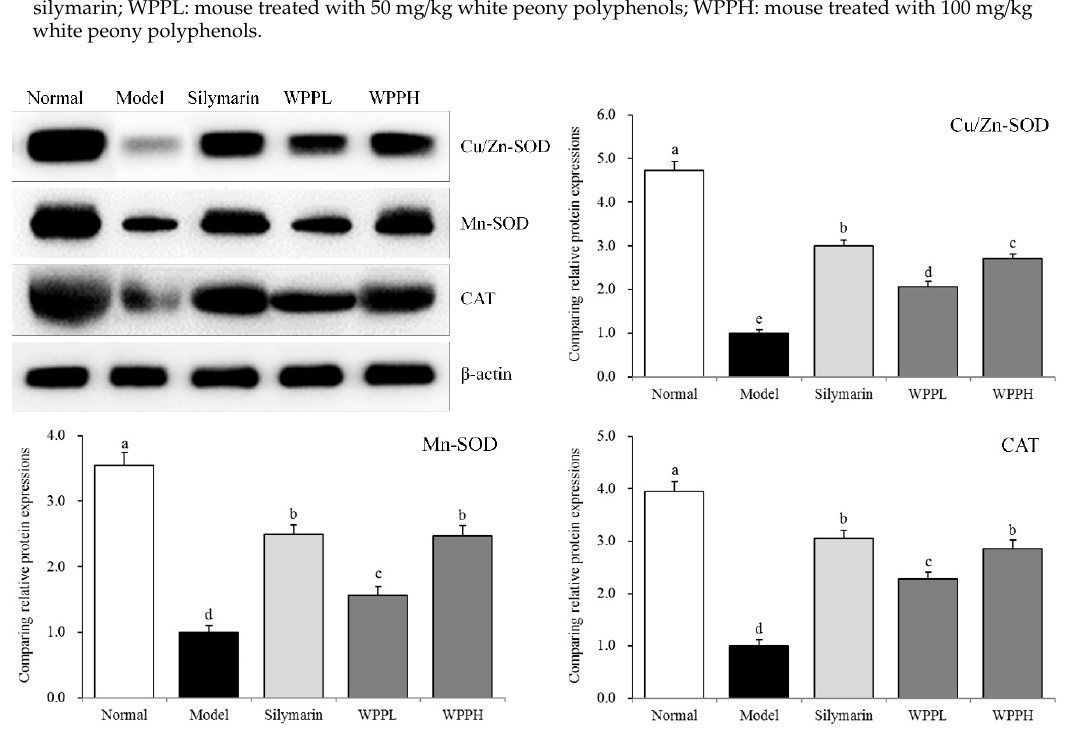
Figure 5. Cu-Zn- SOD, Mn-SOD, and CAT protein expression in the liver tissues of mice. a–d Using Tukey’s honestly significant different test, there was no significant difference between the two groups with the same superscript ( p > 0.05), and there was a significant difference between the two groups with different superscript ( p < 0.05). Silymarin: mouse treated with 100 mg/kg silymarin; WPPL: mouse treated with 50 mg/kg white peony polyphenols; WPPH: mouse treated with 100 mg/kg white peony